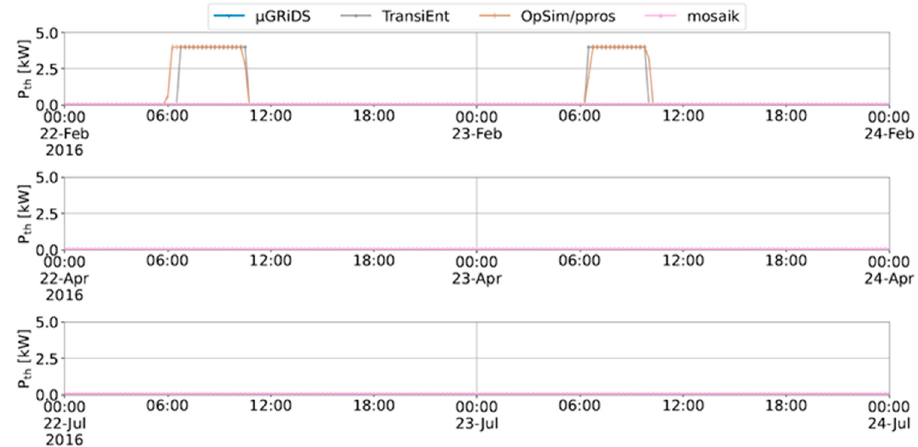
Figure 9. Thermal output of the heaters for two days in February (winter), April (transition) and July (summer). Compared are the different results among the four models involved.